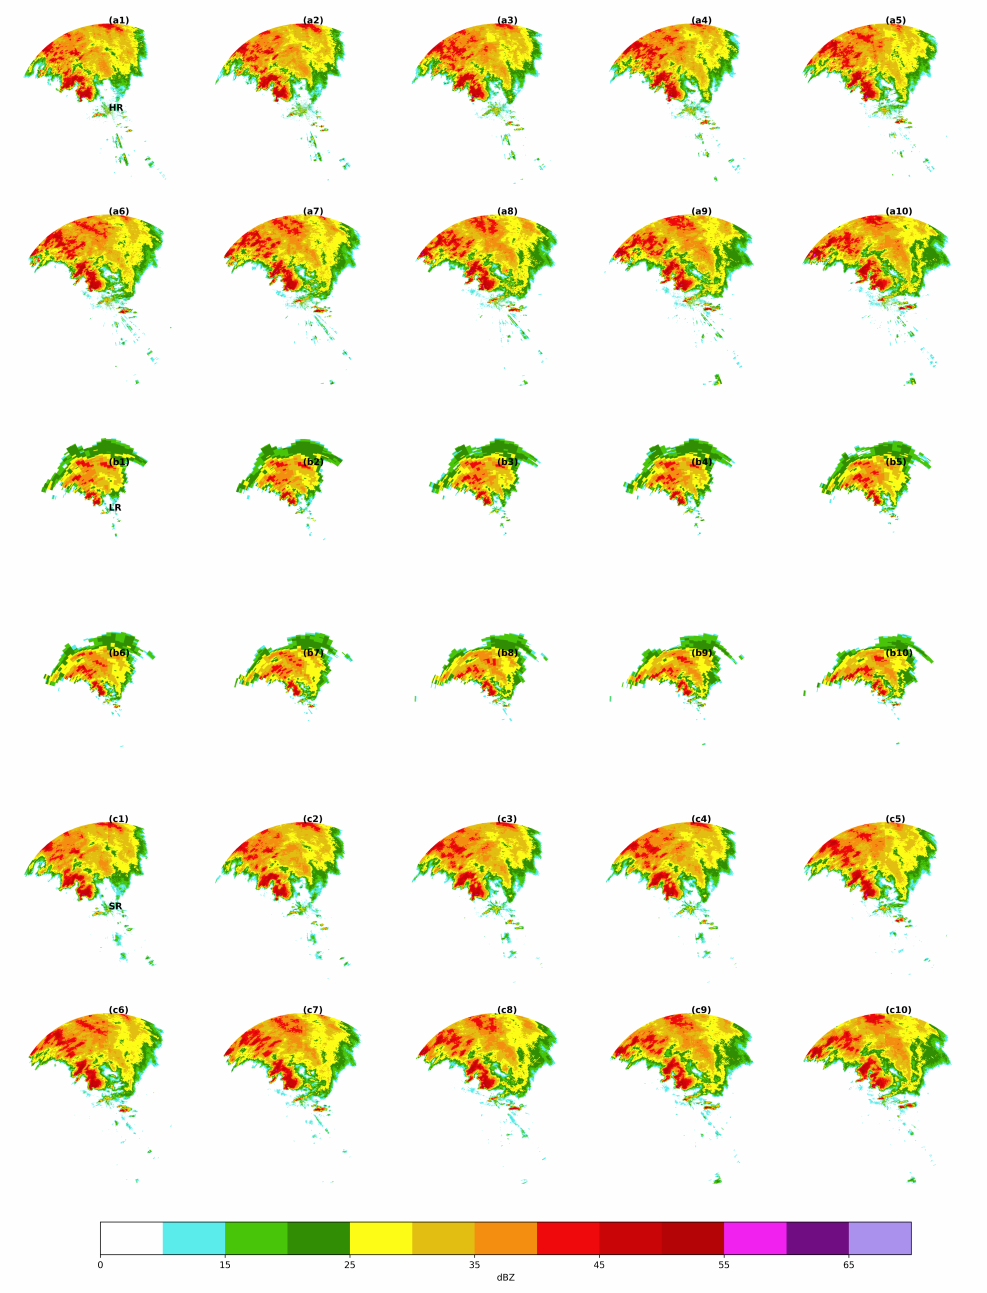
Figure A4. Tornado data on the scaling factor ×